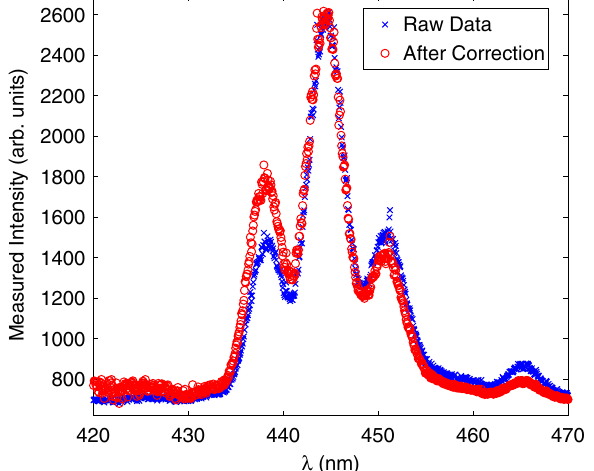
FIG. 13. (Color) A typical measured optical klystron spectrum before and after the correction using the grating efficiency curve. The raw spectrum is represented by blue crosses while the corrected spectrum is shown using red